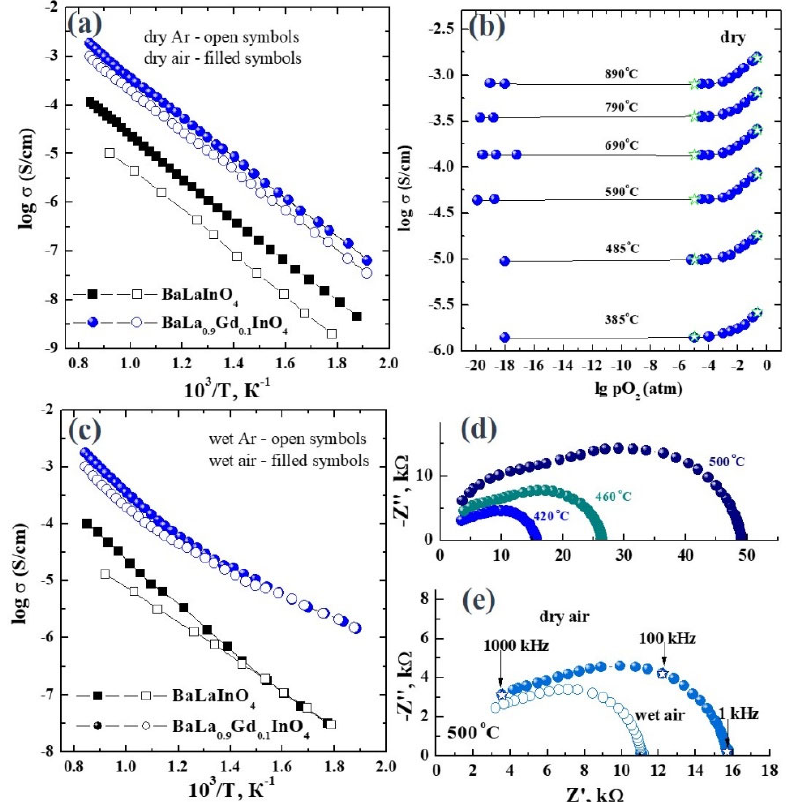
Figure 2. Temperature dependencies of conductivity for doped BaLa 0.9 Gd 0.1 InO 4 and undoped BaLaInO 4 compositions under dry ( a ) and wet ( c ) conditions; dependencies of conductivity vs. oxygen partial pressure ( b ); EIS-plots for BaLa 0.9 Gd 0.1 InO 4 composition at different temperatures under dry air ( d ) and under dry and wet air ( e ) at 500 °C.